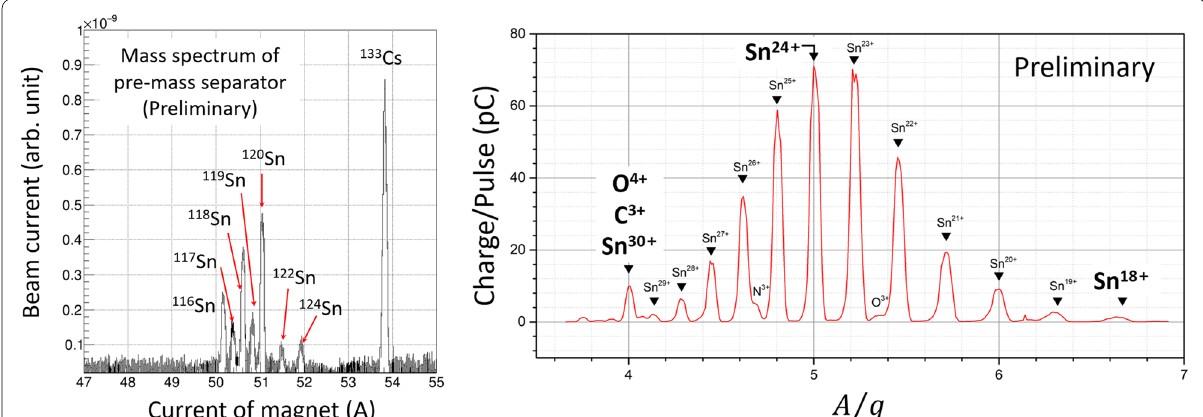
Fig. 9 Mass spectrum of the pre-mass separator for the Sn isotopes extracted by RILIS at TIS (left) and the measured A / q spectrum (right)